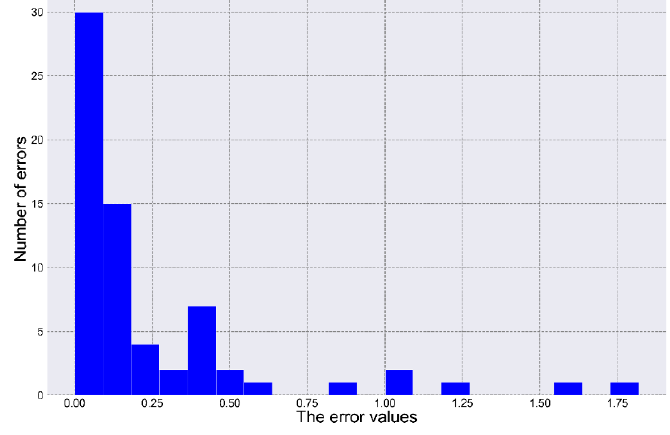
Figure 6. Histogram of errors.